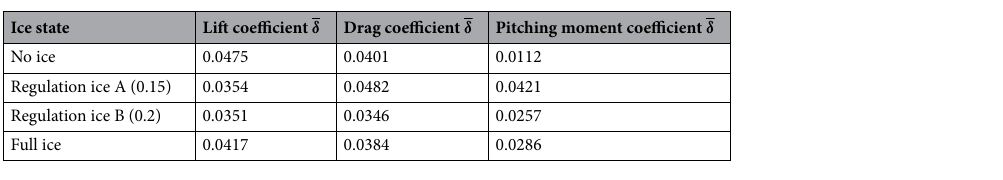
Table 3. Calculation results of repeatability parameters ( δ